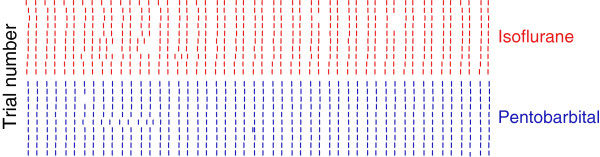
Entrainment of a single unit recorded in the experimental condition. Raster plots of the response evoked by 50-Hz, 500-μm sinusoidal vibration delivered for 0.5s.